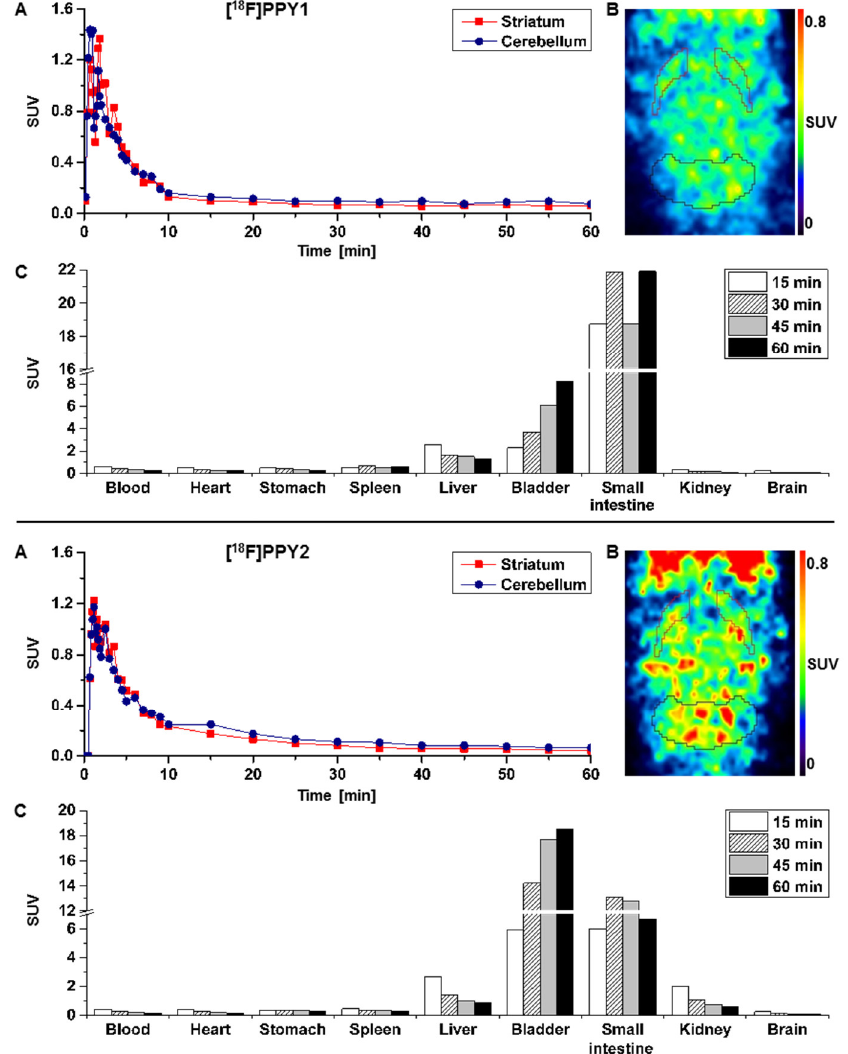
Figure 9. ( A ) Time–activity curves with SUVs for striatum and cerebellum; ( B ) Representative horizontal PET images (0–10 min) after injection of [ 18 F] PPY1 and [ 18 F ]PPY2 in CD-1 mice (n = 2, respectively). ( C ) Biodistribution of [ 18 F] PPY1 and [ 18 F ]PPY2 at different time points based on PET imaging (n = 1 and n = 2, respectively).